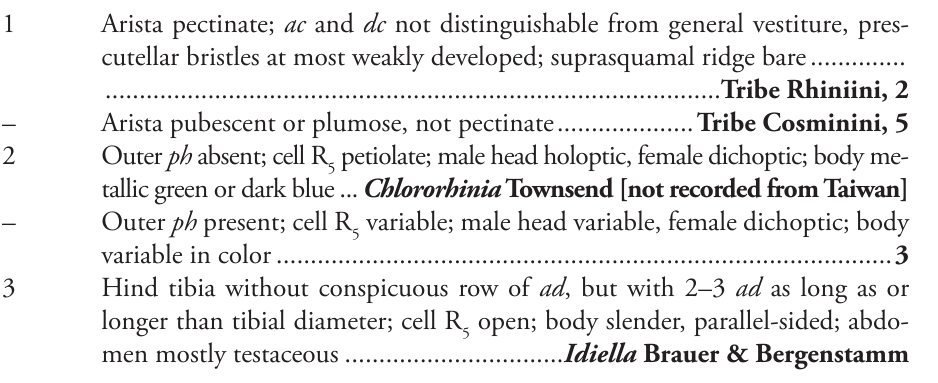
Hind tibia without conspicuous row of ad , but with 2–3 ad as long as or longer than tibial diameter; cell R open; body slender, parallel-sided; 5